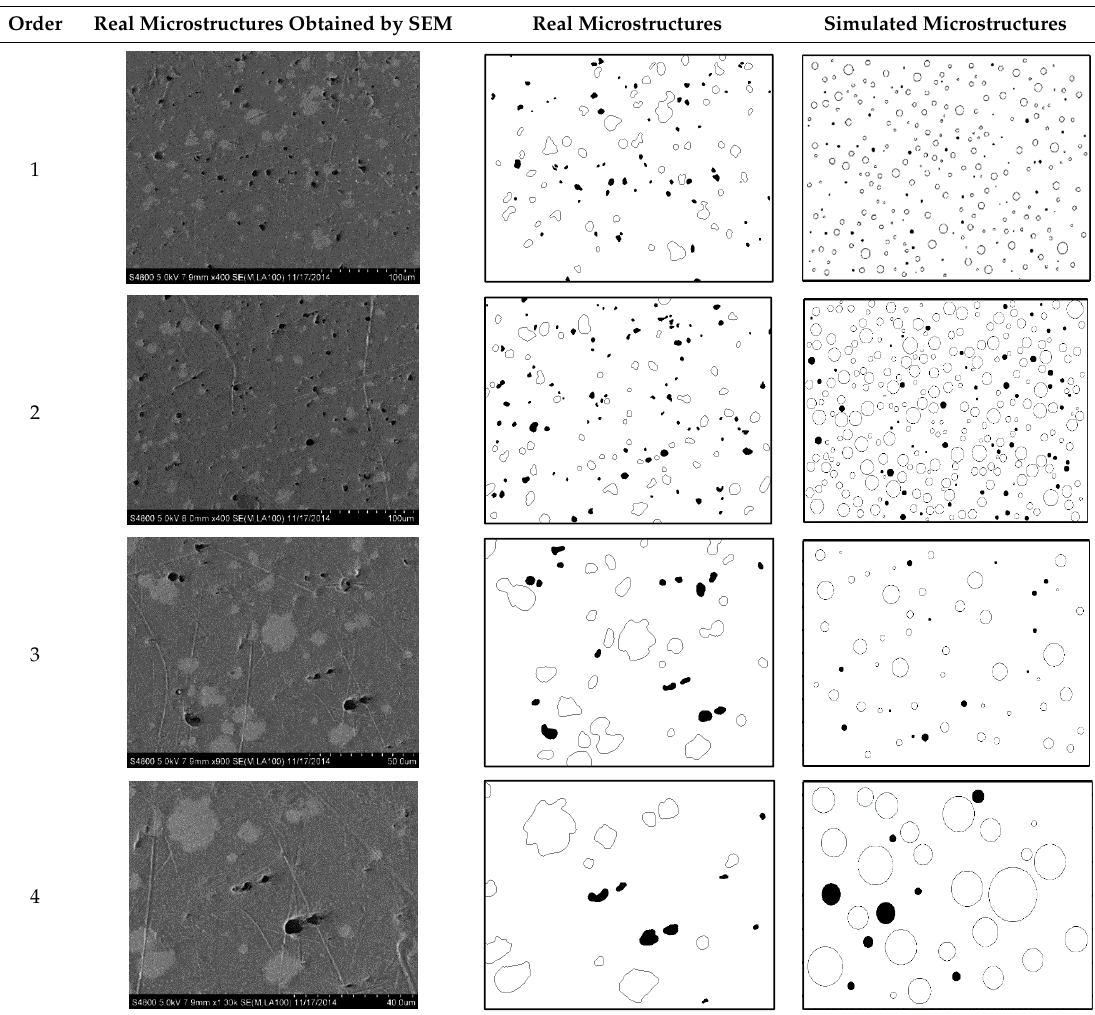
Table 1. Microstructures of Al/PTFE (polytetrafluoroethylene) including real microstructures obtained by SEM, real microstructure-based models after image processing and simulated microstructures. Al particles and microvoids are represented by white hollow geometries and black solid geometries, respectively.